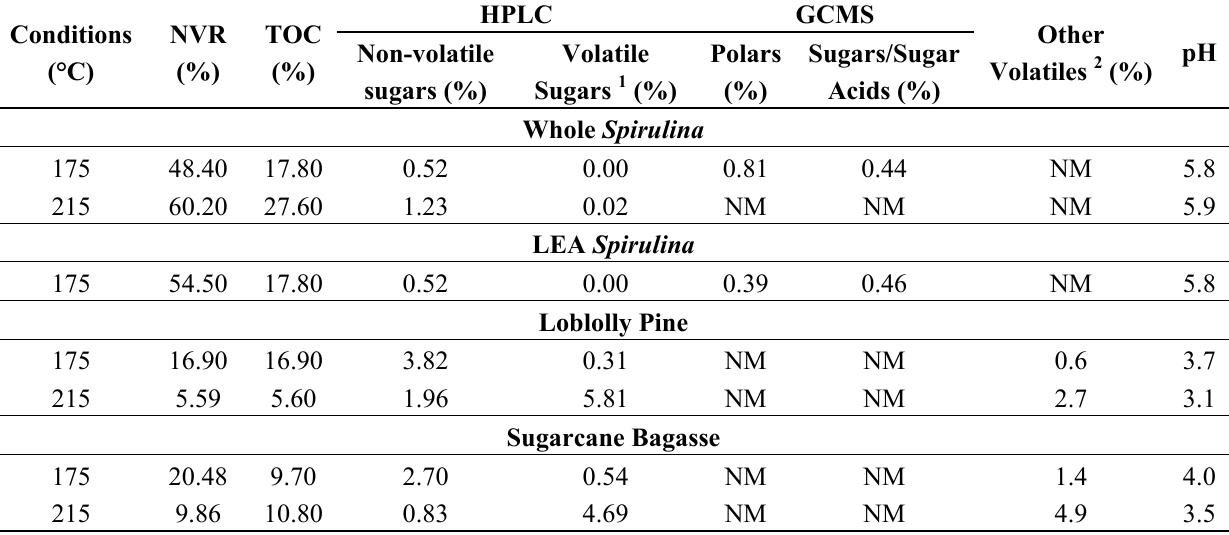
Table 3. Compositions of aqueous co-products